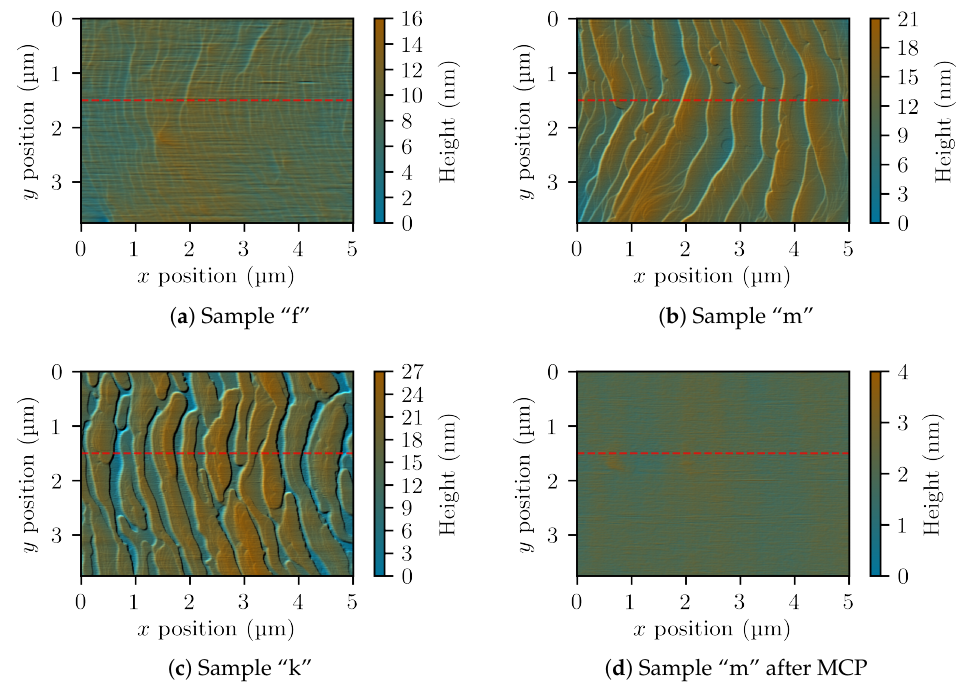
Figure 5. Atomic-force microscopy (AFM) scans of four GaN:Ge layers. Subfigure ( d ) shows the same sample as subfigure ( b ) but after mechano-chemical polishing (MCP). The sections marked by the dashed lines are shown in Figure